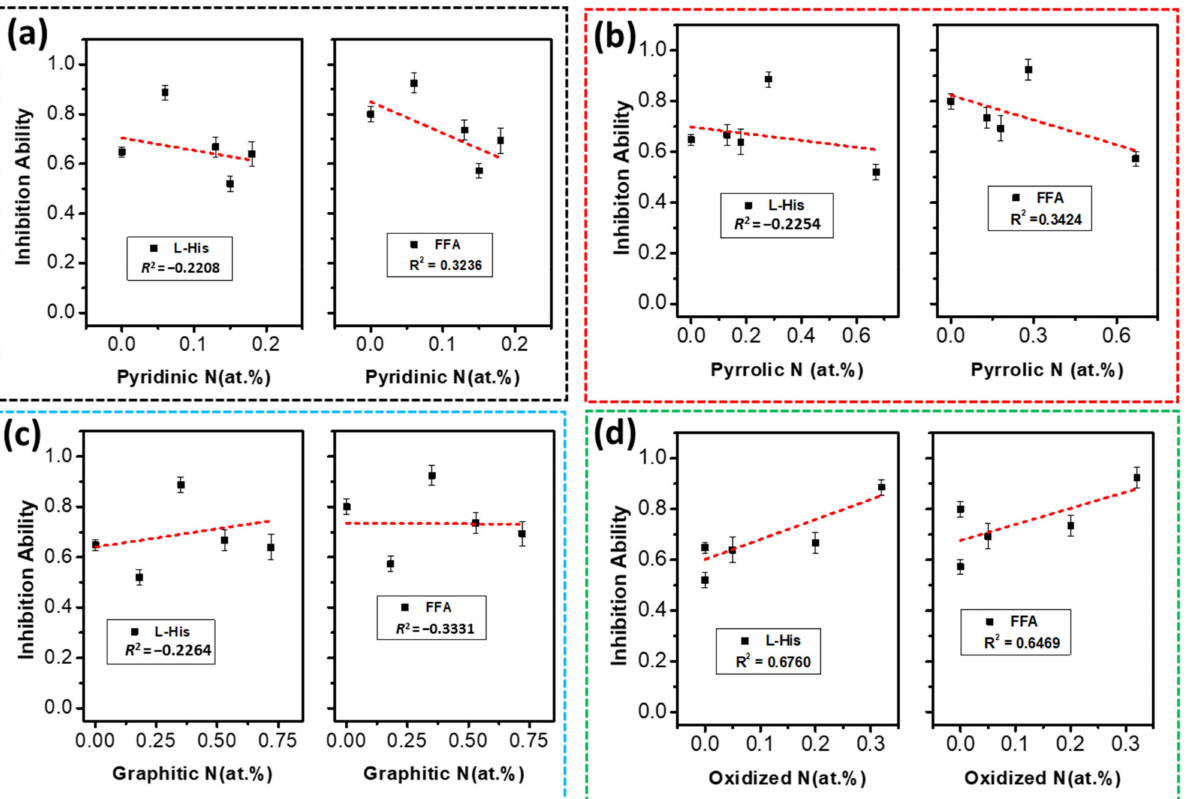
Figure 6. Role of singlet oxygen ( 1 O 2 ) quenchers on ACP degradation rate ( k 1 (ACP)). Correlation between k 1 (ACP) and pyridinic N ( a ), k 1 (ACP) and pyrrolic N ( b ), k 1 (ACP) and graphitic N ( c ), and k 1 (ACP) and oxidized N ( d ). Quenching studies were carried out at C ACP = 10 mg L − 1 , C Catalyst = 100 mg L − 1 , C PMS = 0.5 mM, C FFA = C L-His = 50